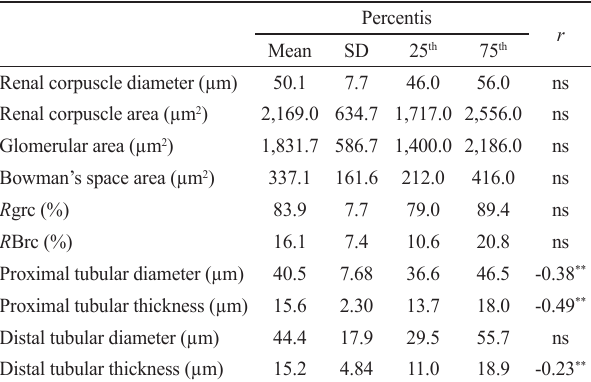
Tab. 3. Descriptive statistics values for histometric